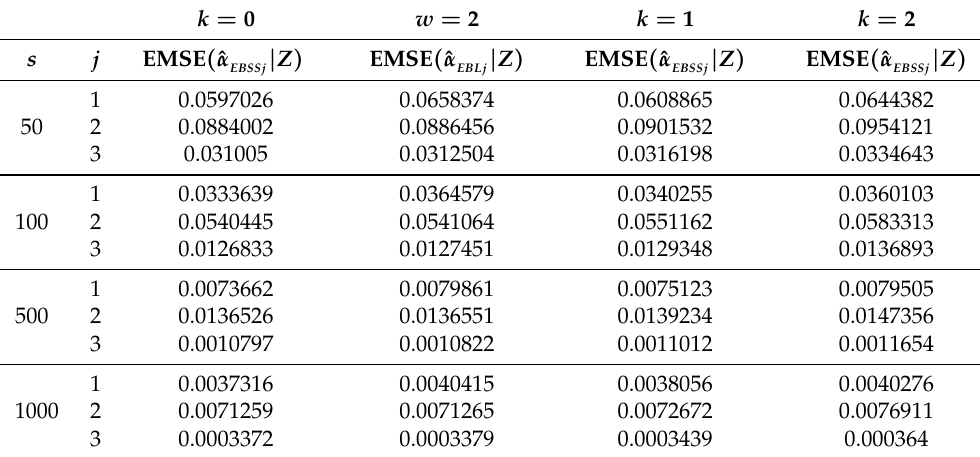
Table 9. Results of calculated EMSE of ˆ α for different s with u = 3 and v = 4 using data from Table